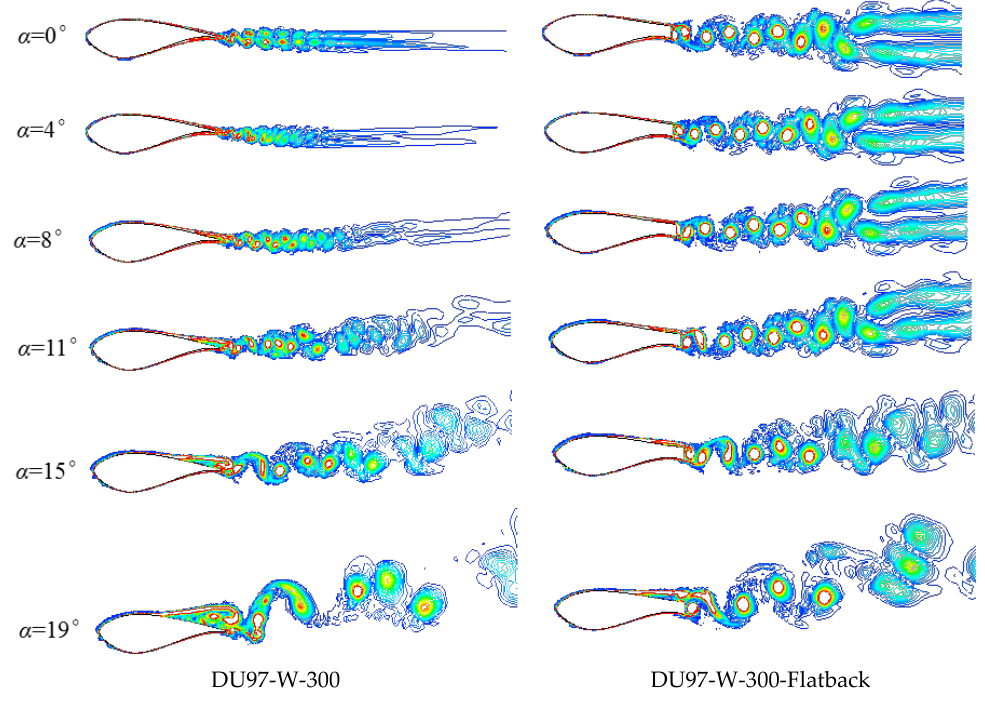
Figure 13. Vorticity contours.